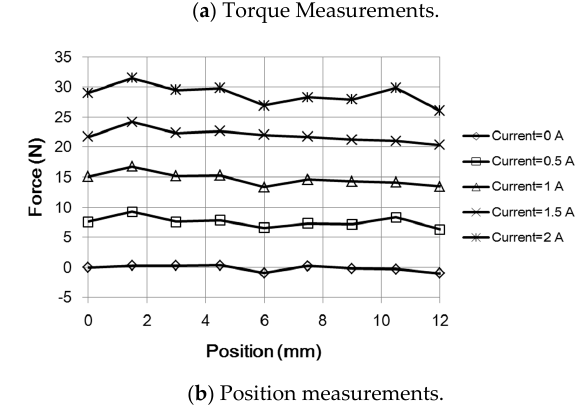
Figure 15. Torque and force measurement of the motor with different current excitations.